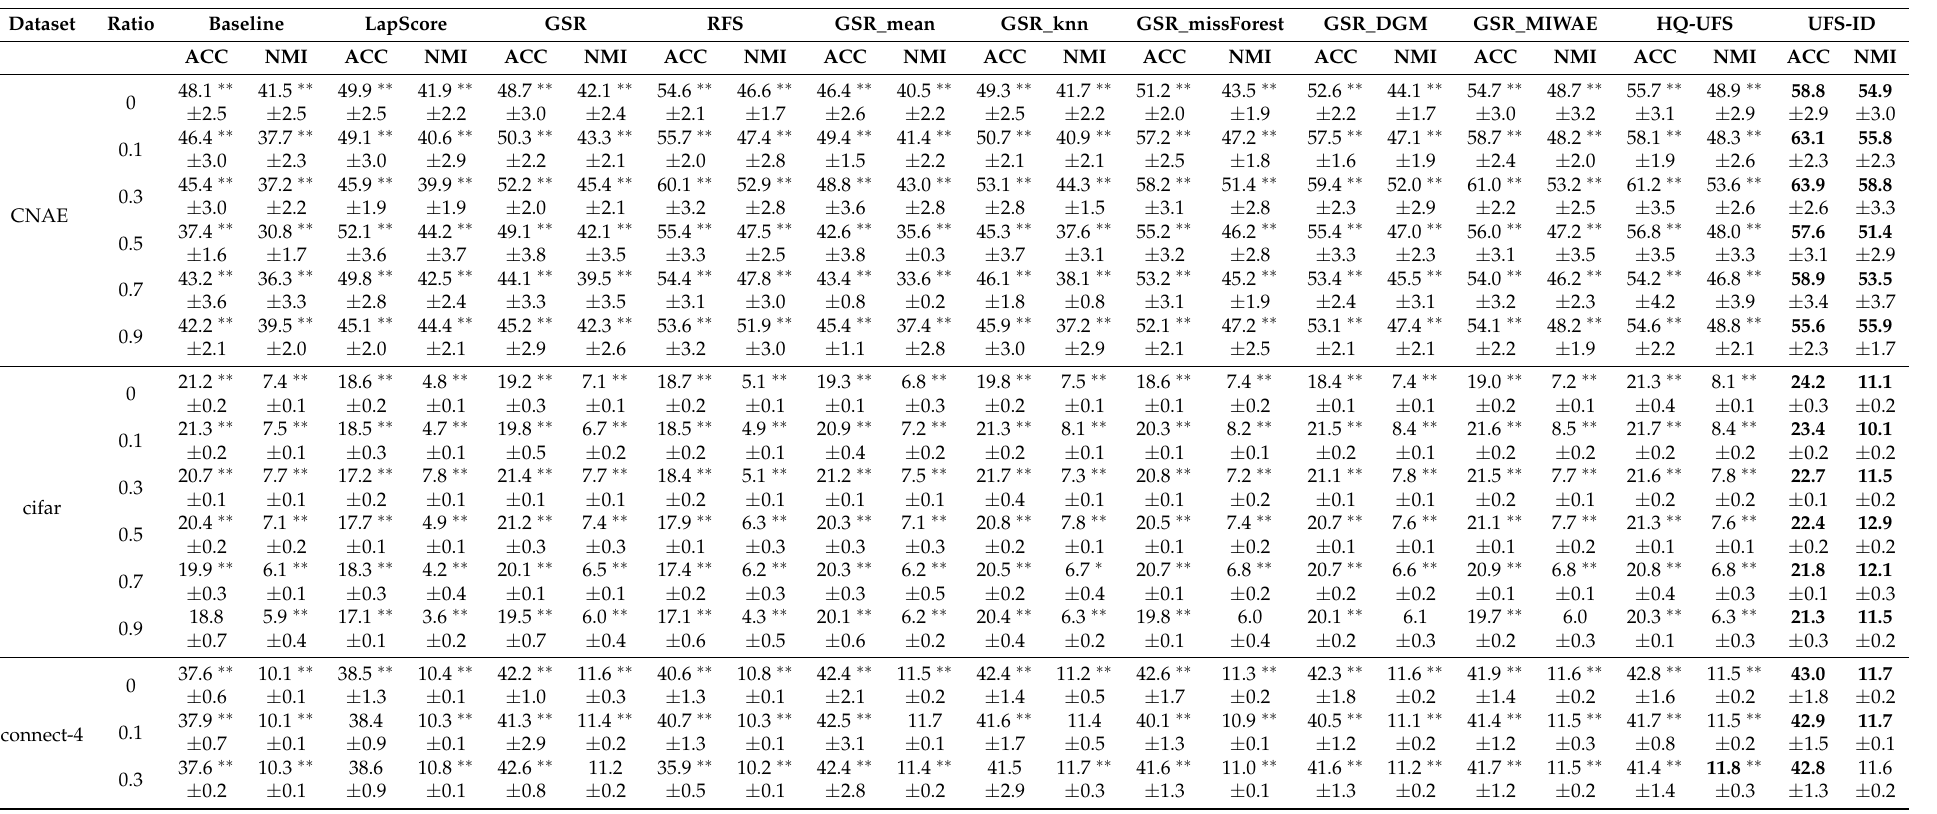
Table 3. ACC and NMI results for different data sets obtained by all approaches at different instance miss rates. The bold numbers denote the best results for the entire row for the same evaluation metric. Specifically, the symbols “*” and “**” indicate that our UFS-ID method had significantly different outcomes with p < 0.05 and p < 0.001 on the paired-sample t -test at the 95% significance level, compared with other competing